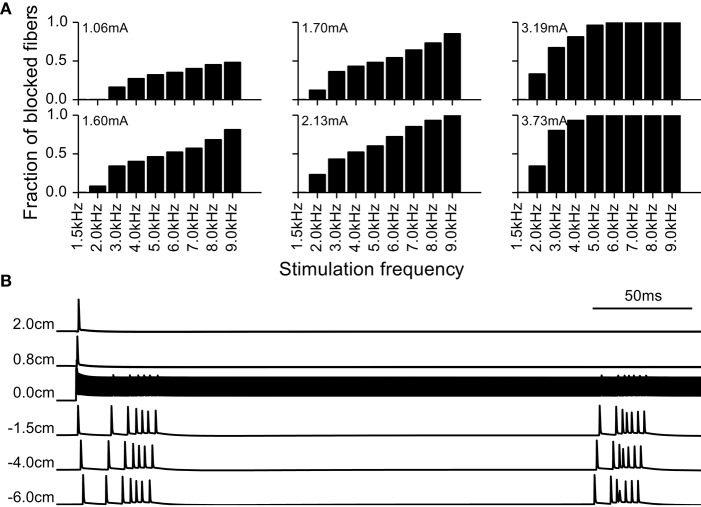
Block of action potential conduction by high frequency stimulation. (A) Fraction of model nerve fibers undergoing conduction block at different stimulation frequencies and amplitudes. (B) Example of a model nerve fiber undergoing conduction block; node at 0 cm is the closest to the extracellular electrode and −6 cm is the location of the node where the intrinsic burst activity was introduced with an intracellular electrode. The intrinsic activity does not propagate through the central node at 0.0 cm, immediately beneath the stimulating electrode.